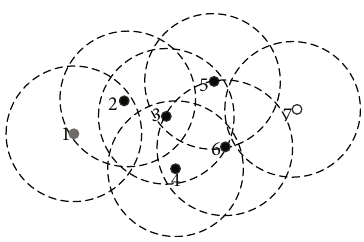
Figure 5: Schematic diagram of the DBSCAN